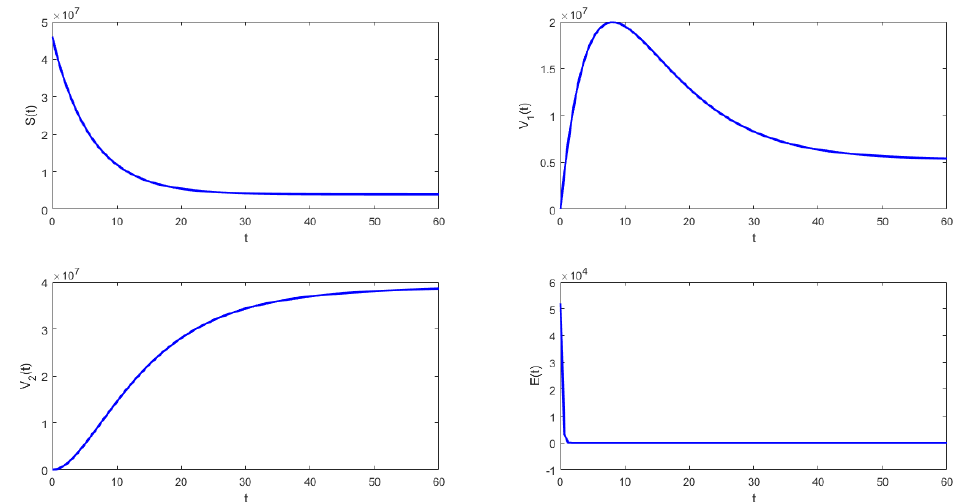
Figure 2. Numerical simulation of system (1) with the following values for the parameters: